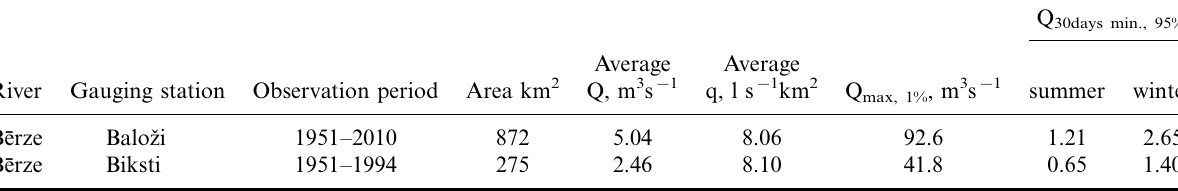
Table 1. Main characteristics of Be¯rze River hydrology